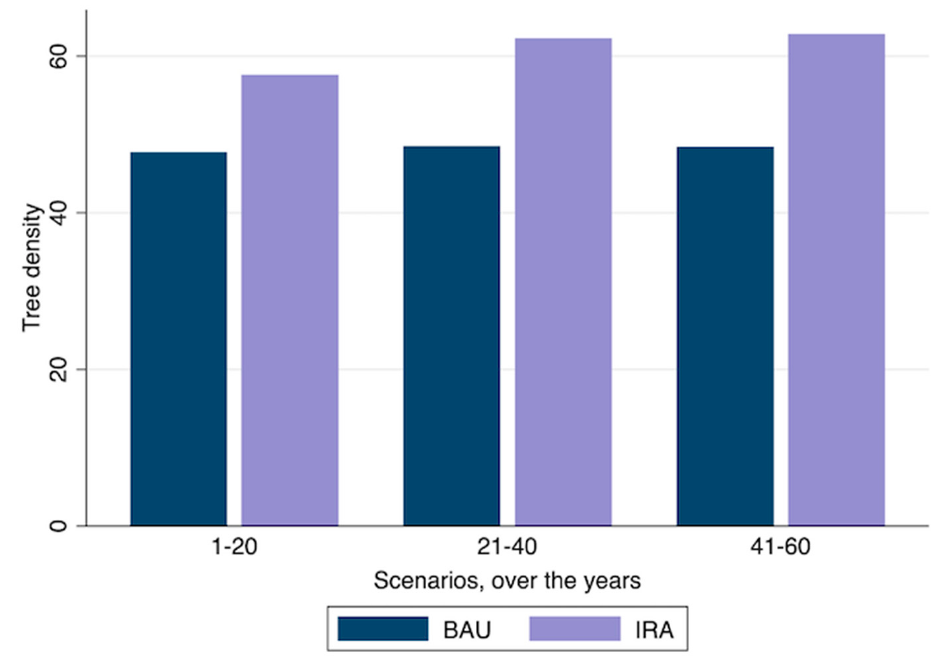
Figure A3. Simulation results: tree density over time.